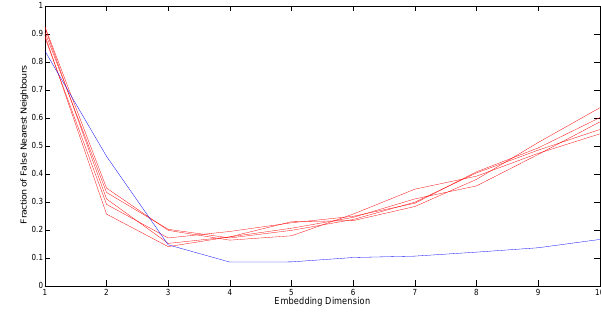
Figure 10. Mutual information plotted against time delay for the original detrended data (blue curve) with the mutual information for the surrogate data (red curve) for TEC data measured at Lagos for the quietest day of March 2011.